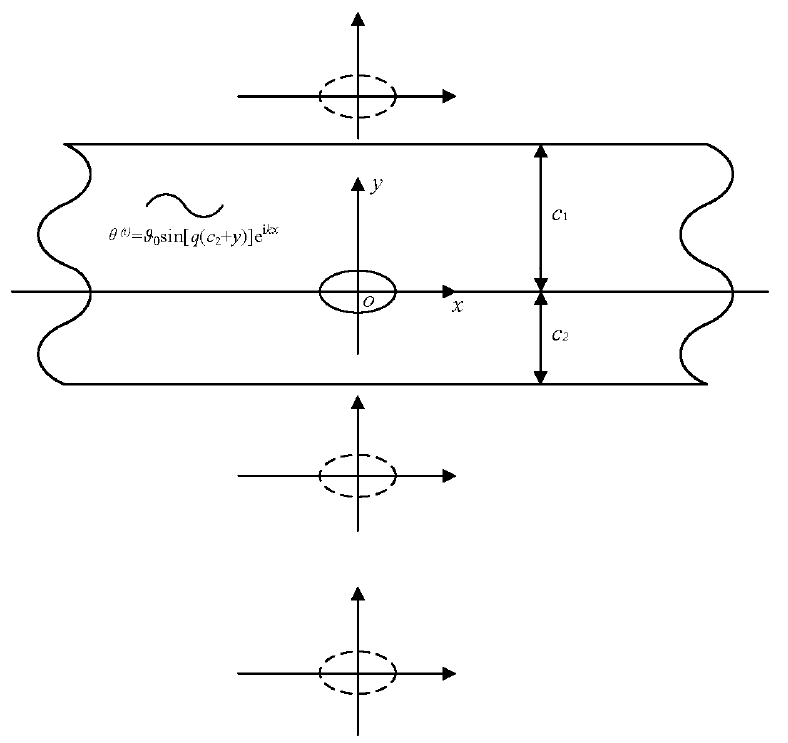
Figure 1. Laser pulse heating on specimen.